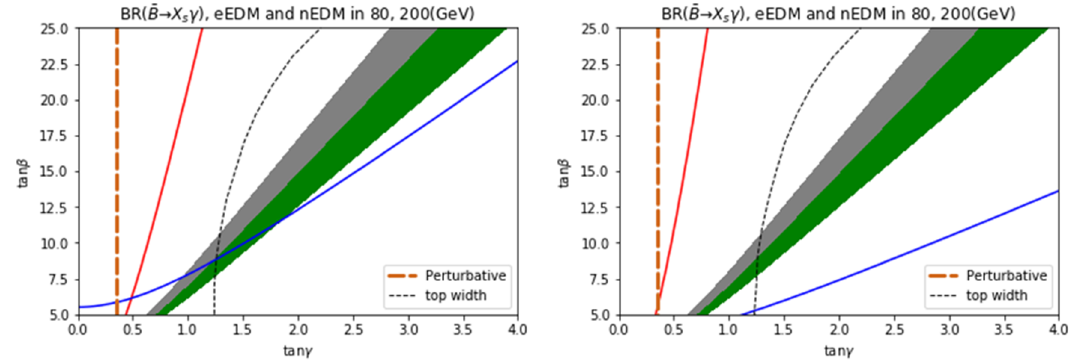
Figure 14 . The allowed regions from ¯ B → X s γ (within the green and grey shaded areas), eEDM (above the blue line) and nEDM (to the right of the red line) in the [ tan γ, tan β ] plane, with M = 80 GeV, M = 200 GeV, θ = − 0 . 3 , and δ = 0 . 975 π (left) or 0 . 985 π (right). We also show H + 2 H + 3 constraints from the top-quark width (black dotted line) and perturbativity (orange dashed line), wherein the region to the right of the respective curves is